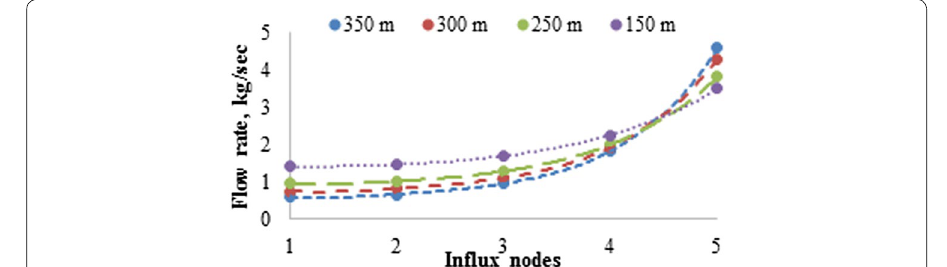
Fig. 10 Influx chart for different production side